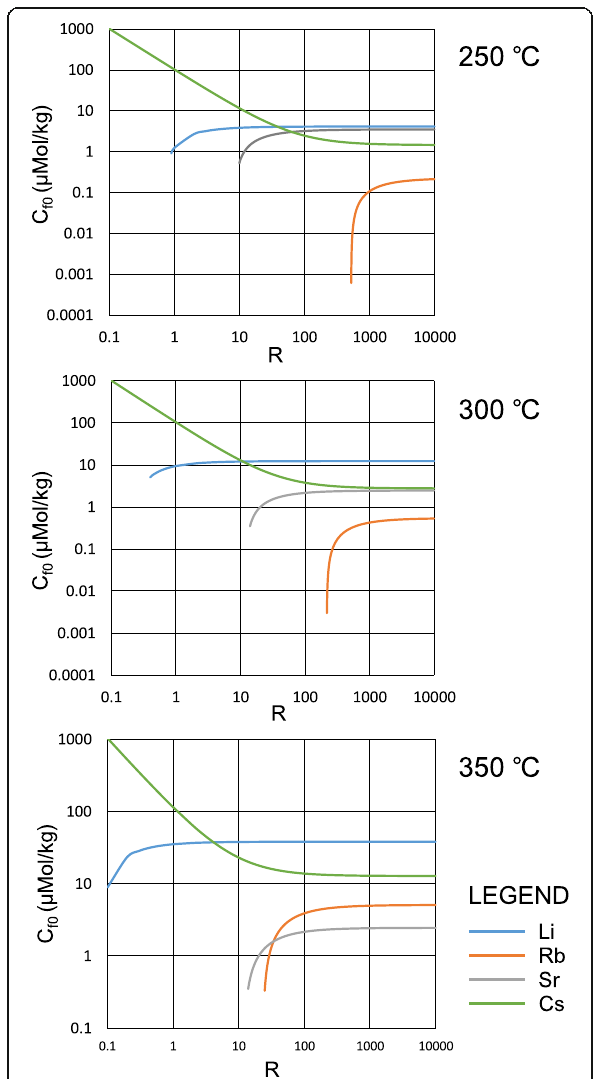
Fig. 8 Estimated Li, Rb, Sr, and Cs concentrations of fluid that had reacted with the pseudotachylyte. The vertical axis shows concentration C f 0 , and the horizontal axis shows fluid-rock mass ratio of 250, 300, and 350°C,